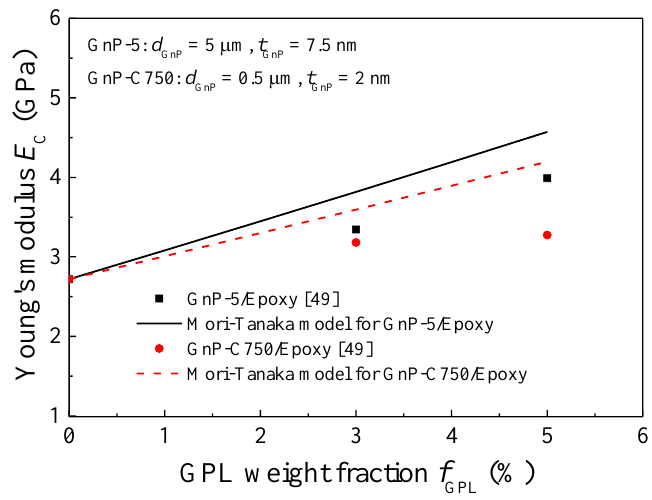
Figure 7. Comparison between present results and experimental data.